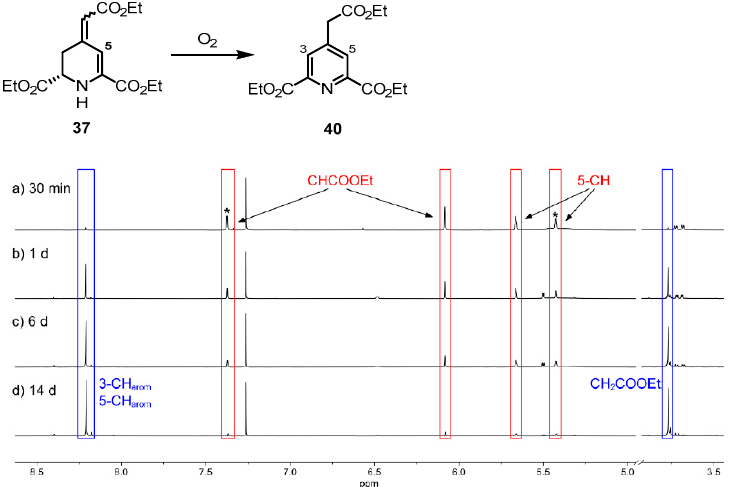
Figure 3. 1 H NMR spectra of 1,2,3,4-tetrahydropyridine 37 after different time intervals. Ratio of diastereomers of cis - 37 and trans - 37 is 55:45. The signals for the minor diastereomer are marked with an asterisk (*). Increasing amounts of aromatic pyridine 40 can be detected. Signals of 37 are marked with red boxes and signals for pyridine 40 with blue boxes.